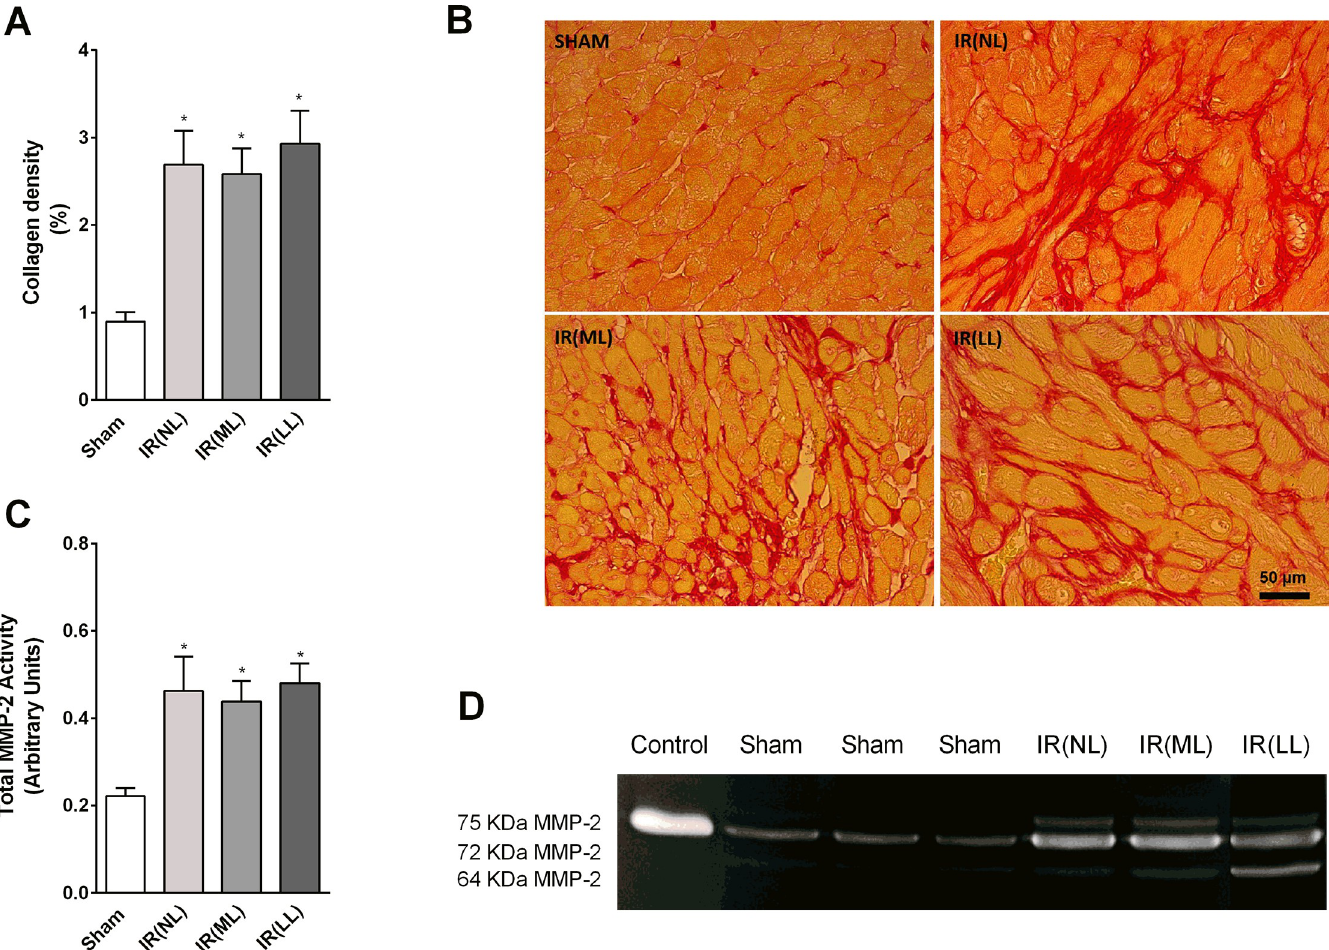
Fig 4. Myocardial fibrosis and MMP-2 activity. (A) Quantification of septal collagen density and (B) photomicrographs of myocardial tissue stained with picrosirius red in rats, 4 weeks after sham-operation (Sham) or acute myocardial ischemia-reperfusion (IR), with no (NL), mild (ML) or large (LL) cardiac lesions. (C) Quantified values of MMP-2 activity and (D) its respective gelatin zymogram. Values are means ± SEM, � vs. Sham, P < 0.05.